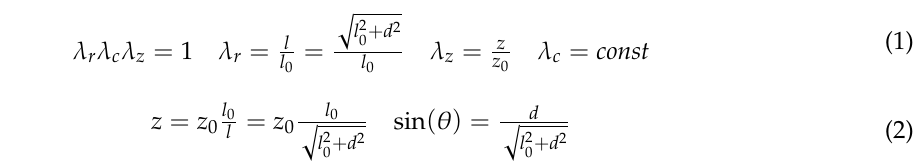
Figure 1. Principle of operation of dielectric electroactive polymer actuator For this circular geometry, the deflection of the DEA membrane is described by the radial stretch λ r , circumferential stretch λ c and thickness stretch λ z [14].